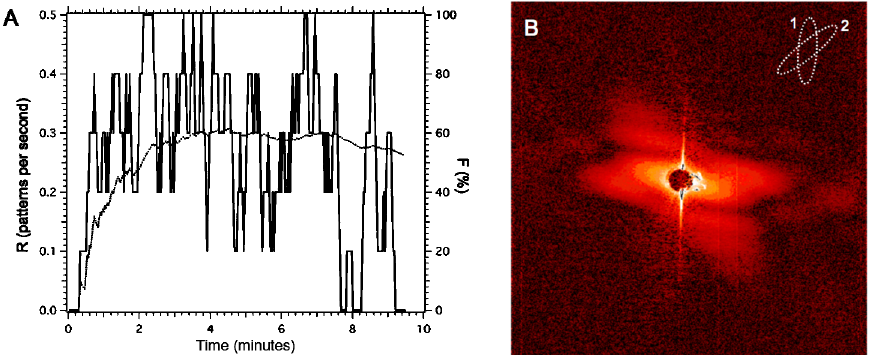
FIG. 4. (A) The instantaneous single particle diffraction acquisition rate R (solid line, 10 s running average) and the cumulative percentage of total camera readouts with evidence of single particle diffraction F for a 10 min experiment with nebulized ellipsoidal nanoparticles (149 diffraction events in 285 camera readouts). FLASH frequency ¼ 500 pulses s (cid:4) 1 . The camera integrated signal from 500 pulses and then readout for 1 s, setting a maximum on the single particle diffraction acquisition rate to 0.5 Hz. Experimental conditions are typically set so F (dotted line) reaches 60% to stay in the single particle diffraction regime. (B) Example diffraction pattern of two different particles hit on two different pulses and detected during a single camera integration/readout cycle. The inset speculates the relative orientation of the two particles (not accounting for out of plane